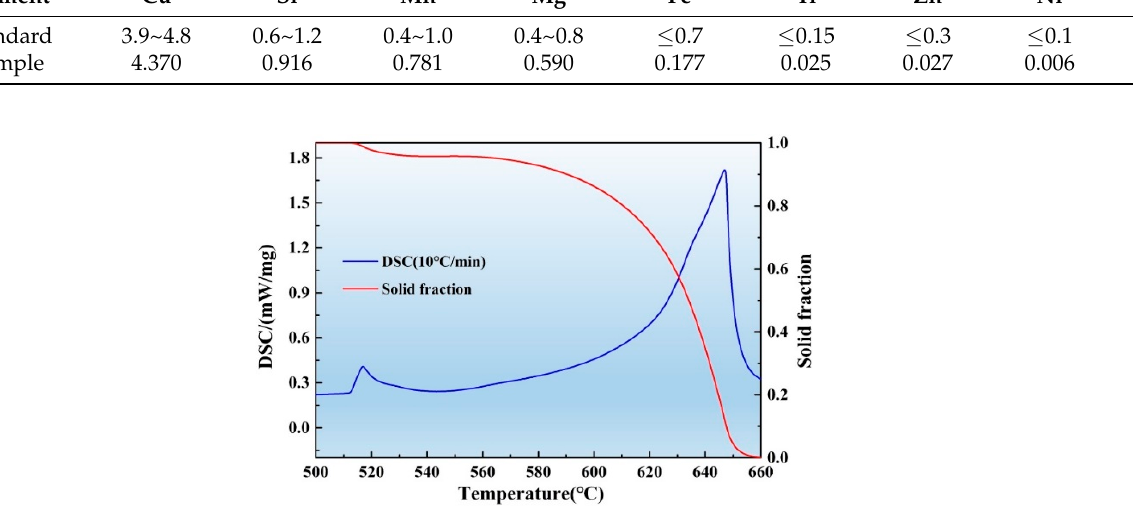
Figure 1. Semisolid range and solid fraction—temperature curve of the 2A14 Al alloy.